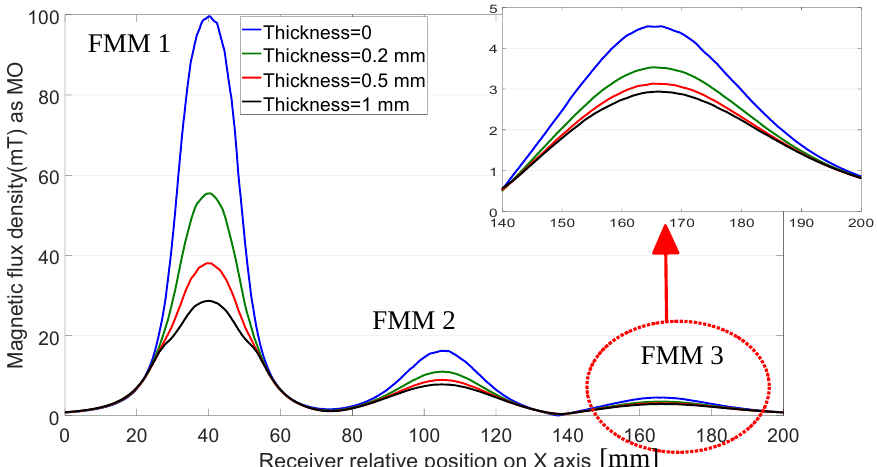
Figure 12. Configuration 2: variations in magnetic flux density (MO) relative to a decreasing reactive- part thickness with a constant reactive-part surface area of 25 mm × 25